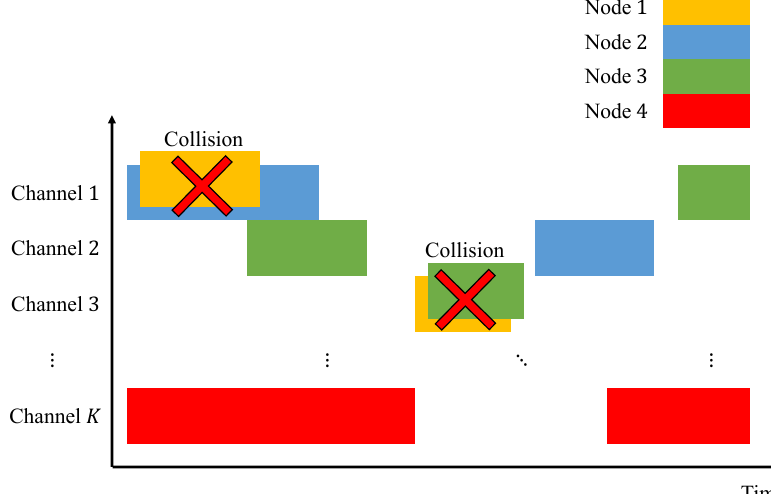
Figure 3. Occupied state of the channels in time